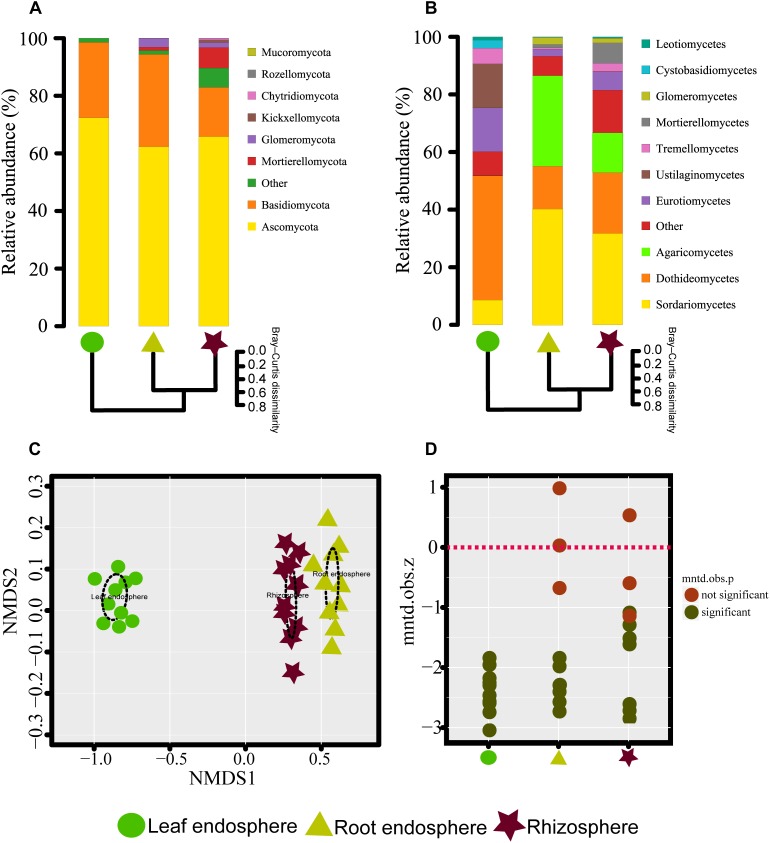
(A,B) Taxonomic composition of the fungal communities associated with Mussaenda kwangtungensis at the phylum and class level, respectively. The hierarchical clustering dendrograms based on Bray–Curtis dissimilarity are shown. (C) Nonmetric multidimensional scaling (NMDS) ordinations based on Bray–Curtis dissimilarity of fungal communities across the three habitat classifications. (D) Variation of standardized effect sizes of the mean nearest taxon distance among different compartments.